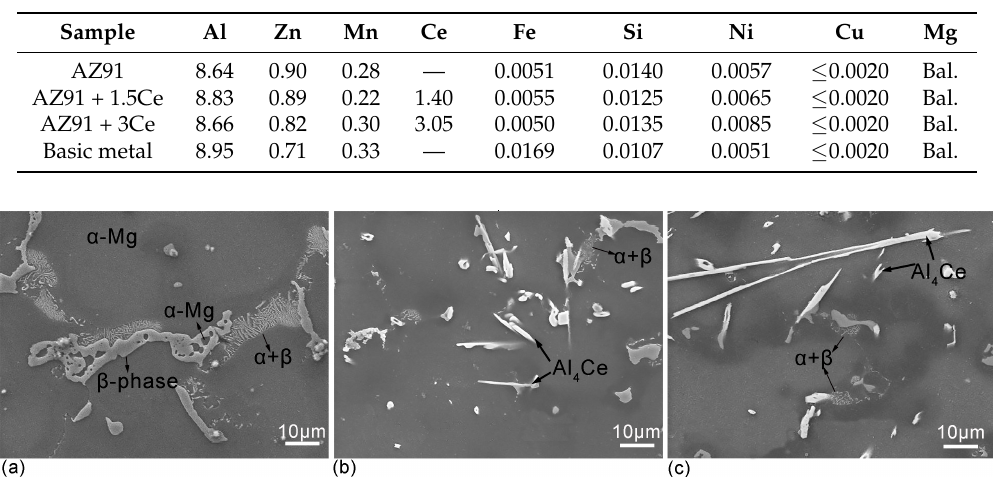
Figure 3. SEM micrograph of the alloys: ( a ) surfacing AZ91 alloy with 0% Ce; ( b ) surfacing AZ91 alloy with 1.5% Ce; ( c ) surfacing AZ91 alloy with 3% Ce.